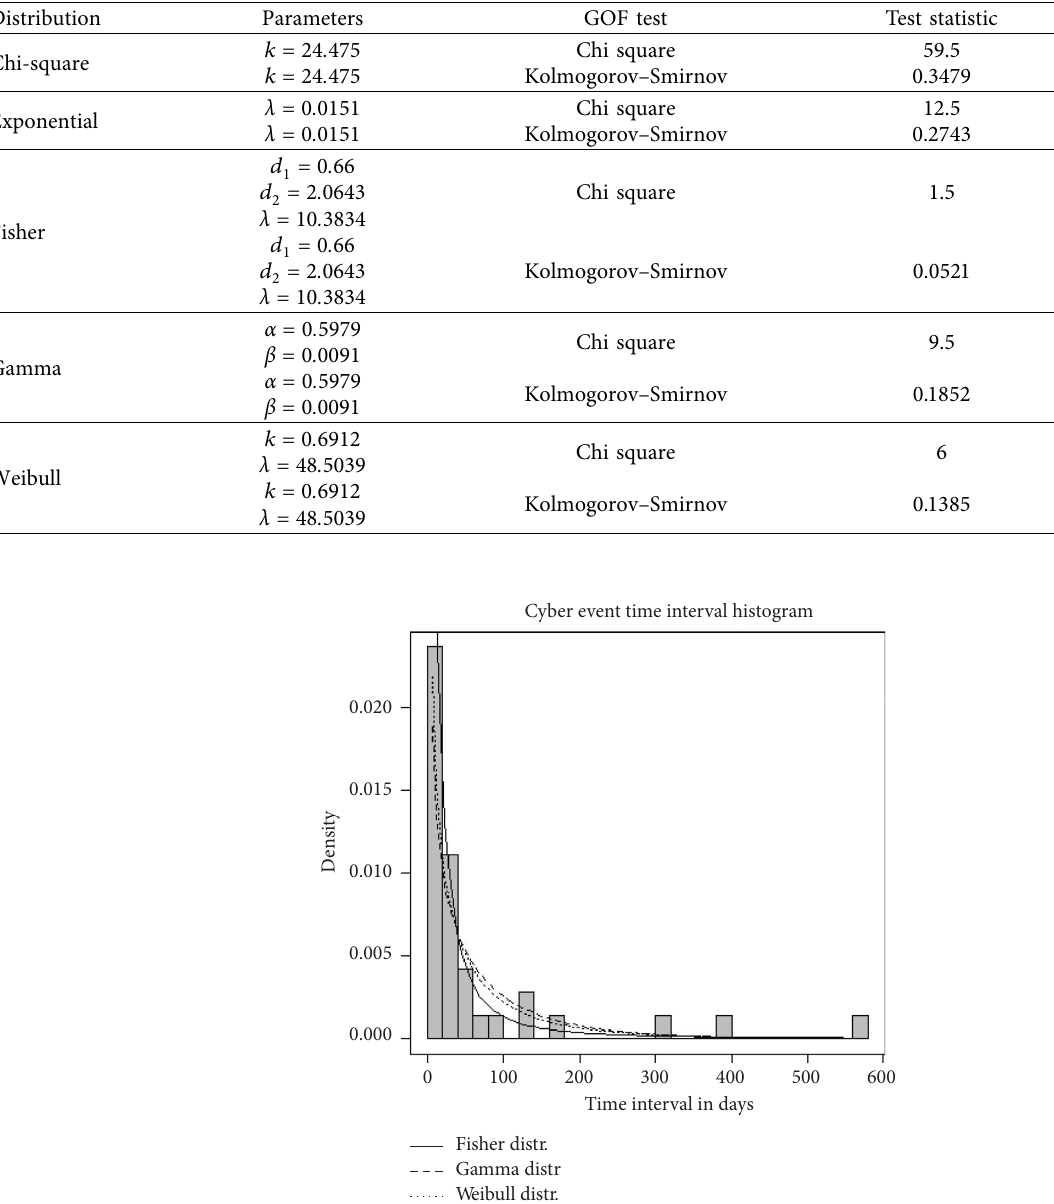
Table 10: Cyber-related data breach loss frequency distribution of GOF tests.